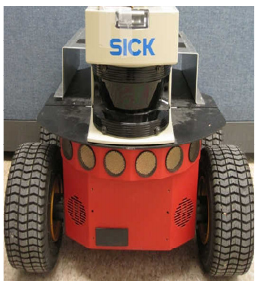
Figure 9. The Pioneer robot platform for experimental